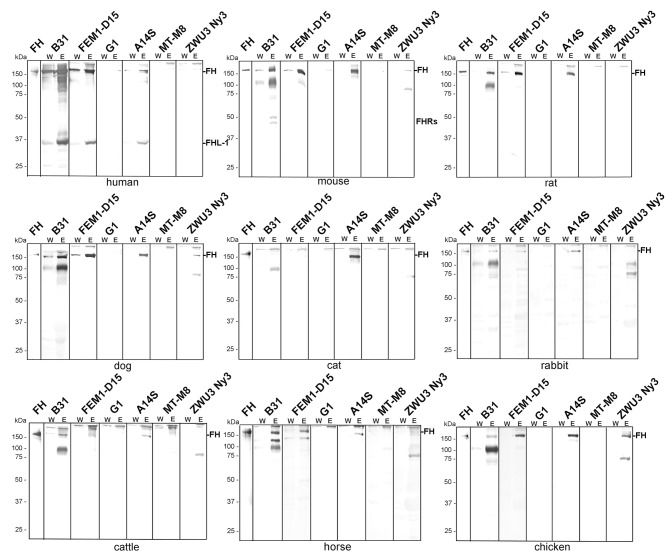
Binding of polymorphic FH to viable LD spirochetes. Indicated Borrelia strains were incubated in human serum as well as in mouse, rat, dog, cat, rabbit, cattle, horse, or chicken serum. Following serum incubation, spirochetes were washed extensively, and surface-bound proteins were eluted using 0.1 M glycine (pH 2.0). Both, the last wash (W) and the eluate (E) fractions obtained from each reaction were separated by glycine-SDS-PAGE under non-reducing conditions and transferred to nitrocellulose. FH molecules were detected by using a sheep anti-FH antibody (1:500). Purified human FH (500 ng) served as a control in all tests. The mobility of the molecular mass standard is indicated on the left of each panel.